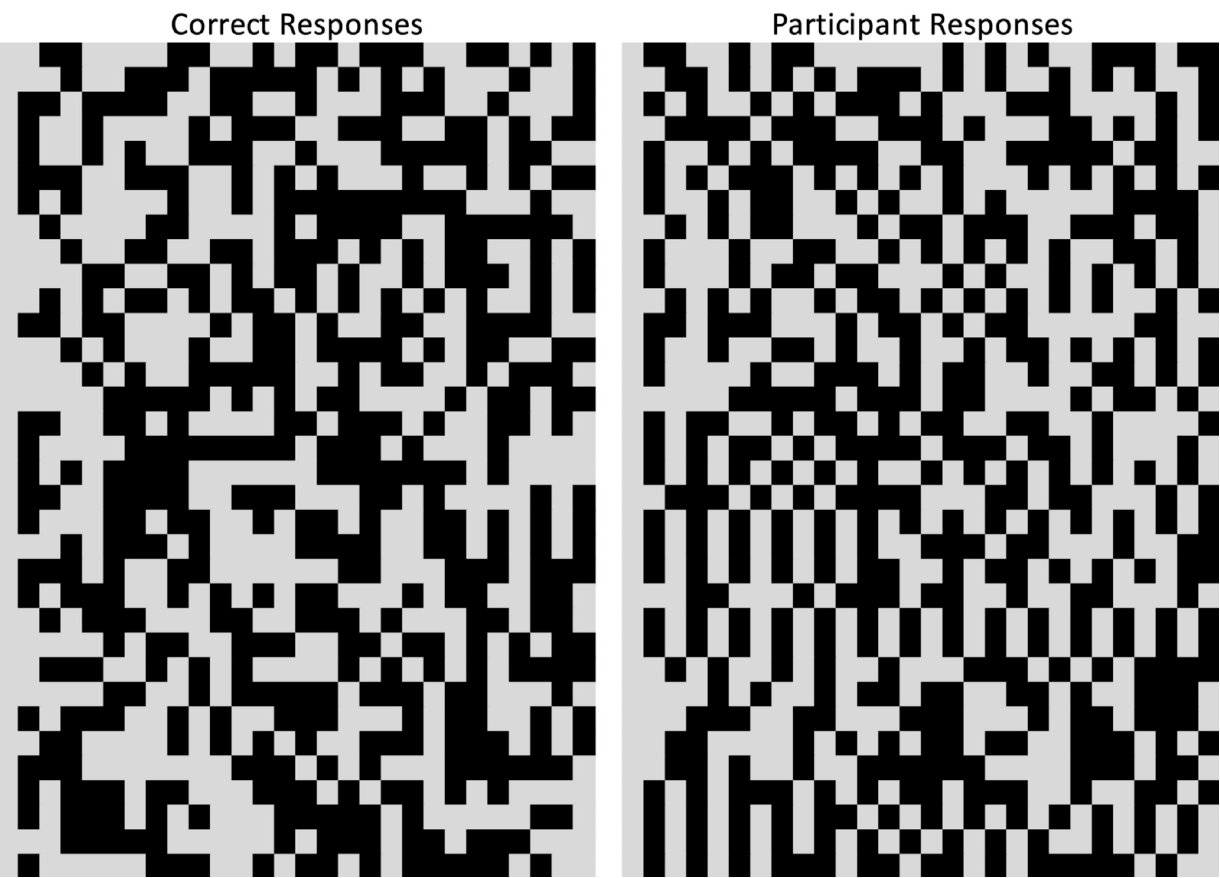
Fig 7. The left panel shows the randomized order of correct test responses. The right panel represents participants’ pattern of key responses, with each row representing an individual’s responses. Both panels are standardized such that the first correct key (left) or first response key (right) is represented by gray squares, with the alternate key represented by black